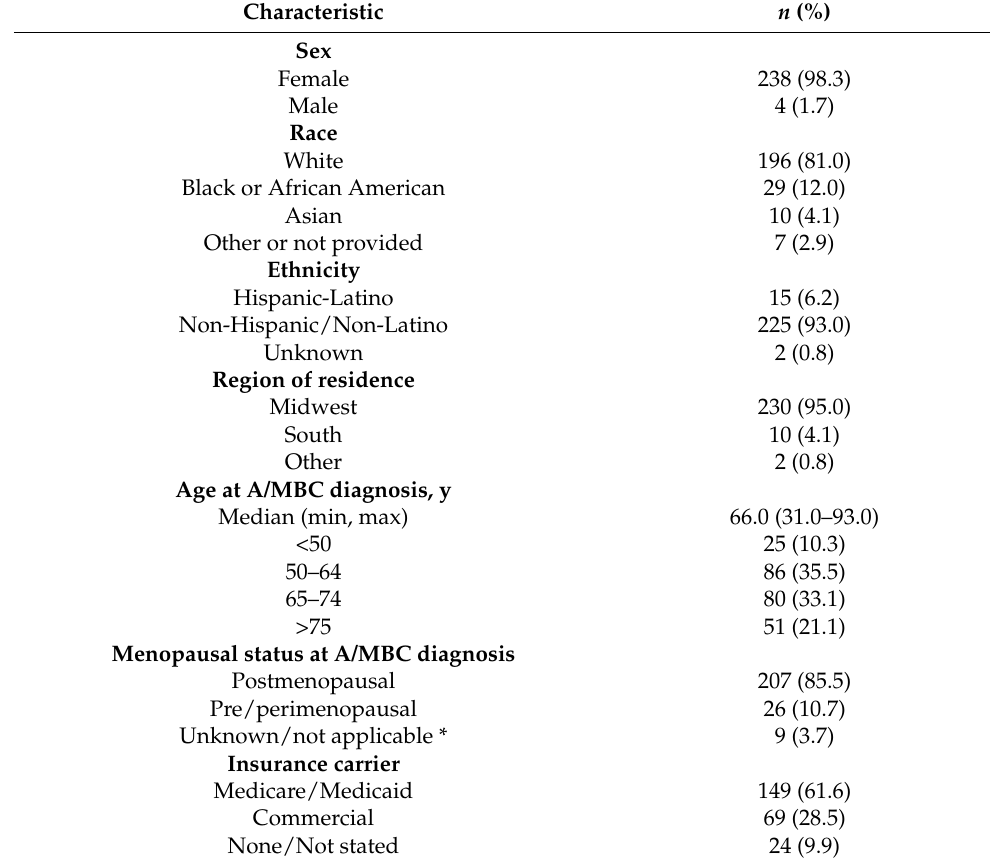
Table 1. Patient demographics and clinical characteristics ( n =